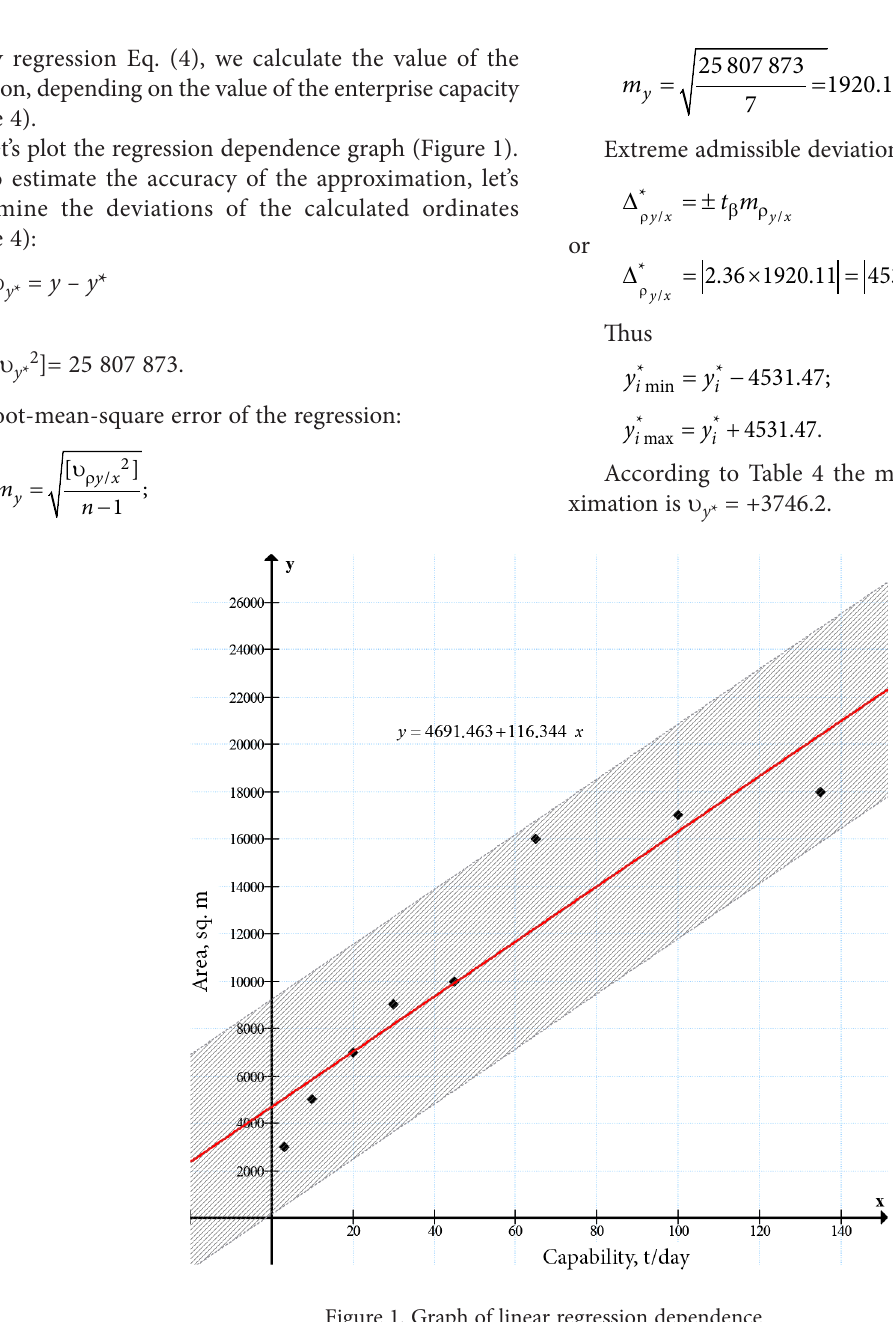
Figure 1. Graph of linear regression